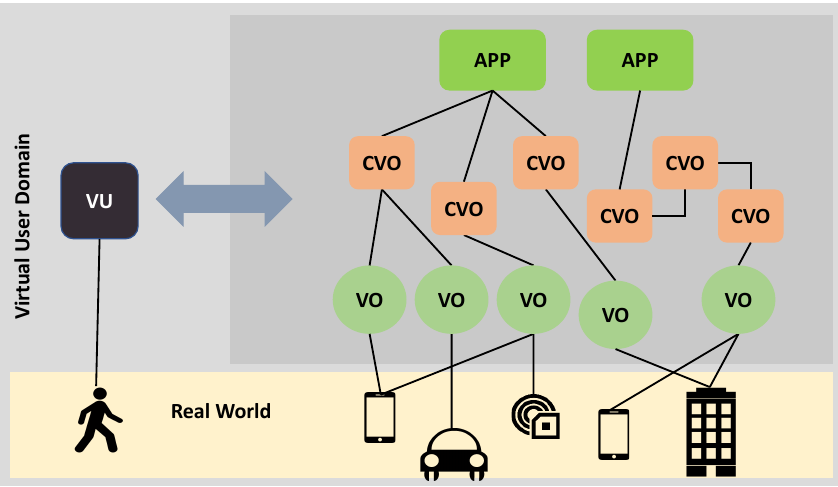
Figure 2. Interaction of the VU with the other major components in an